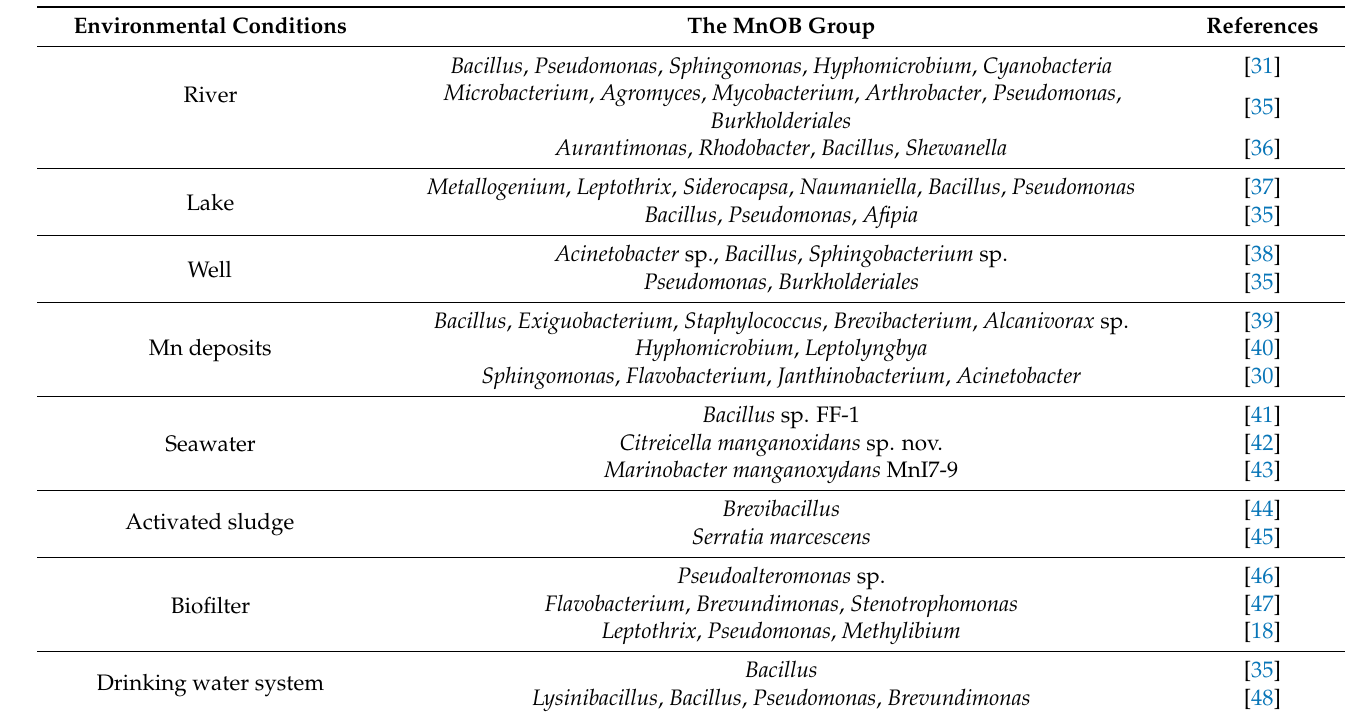
Table 1. The MnOB-related group detected from various Mn